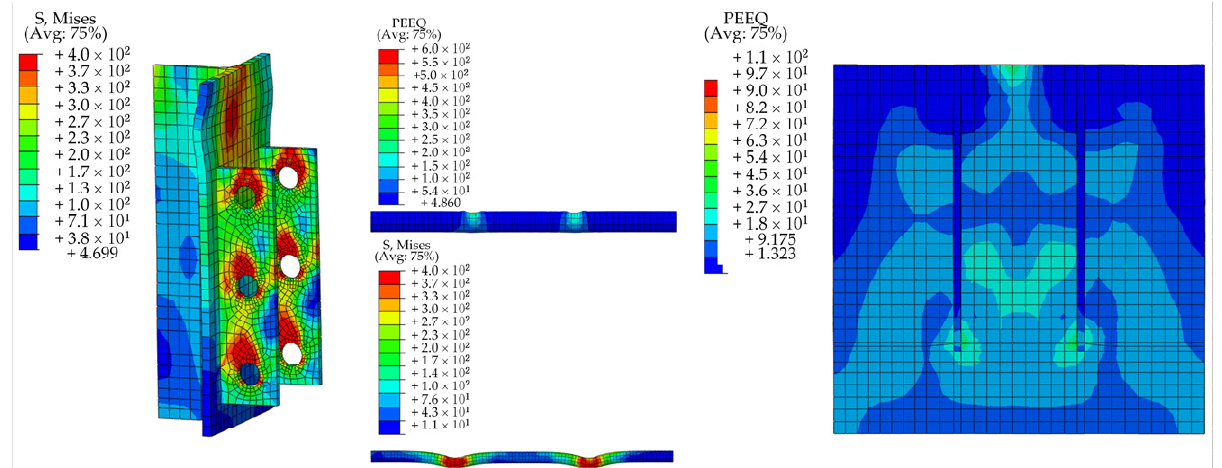
Figure 13. Stress contour of the FE model.